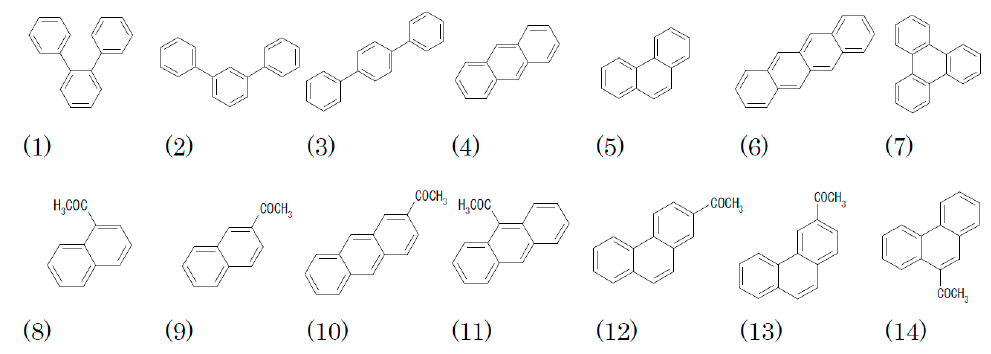
Scheme 1. Structure of analytes appearing in Tables 1 and 2.